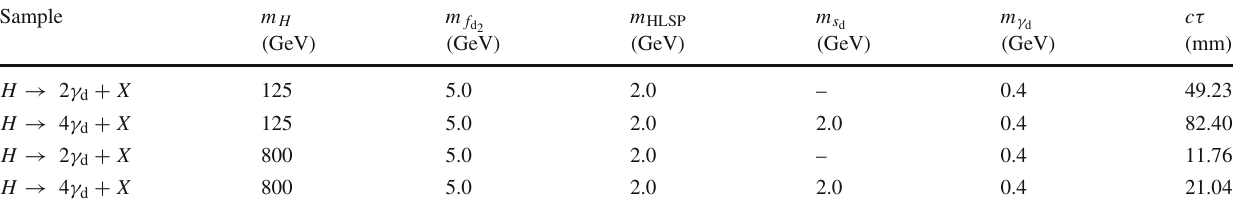
Table 1 Parameters used for the Monte Carlo simulations of the benchmark model Sample m